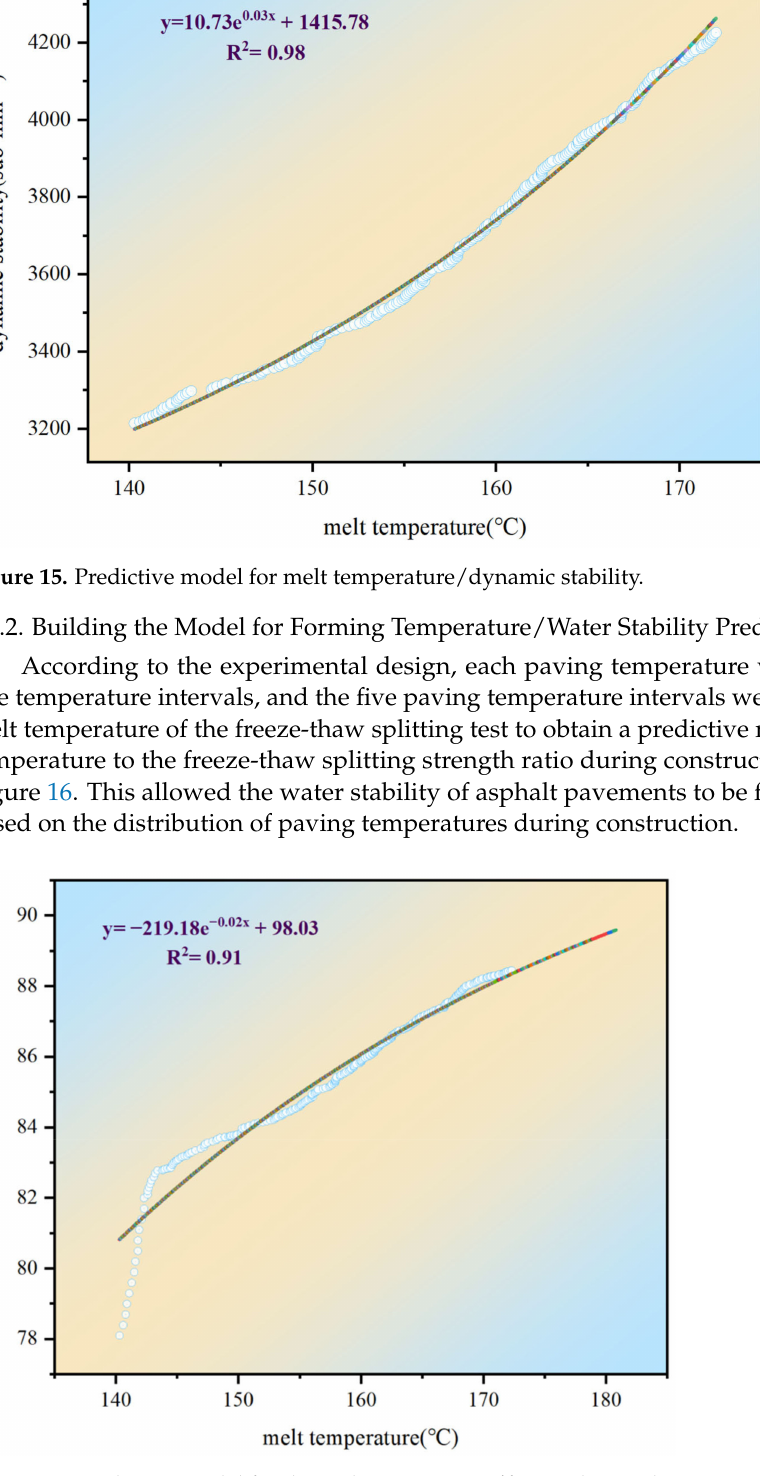
Figure 16. Predictive model for the melt temperature/freeze-thaw splitting strength